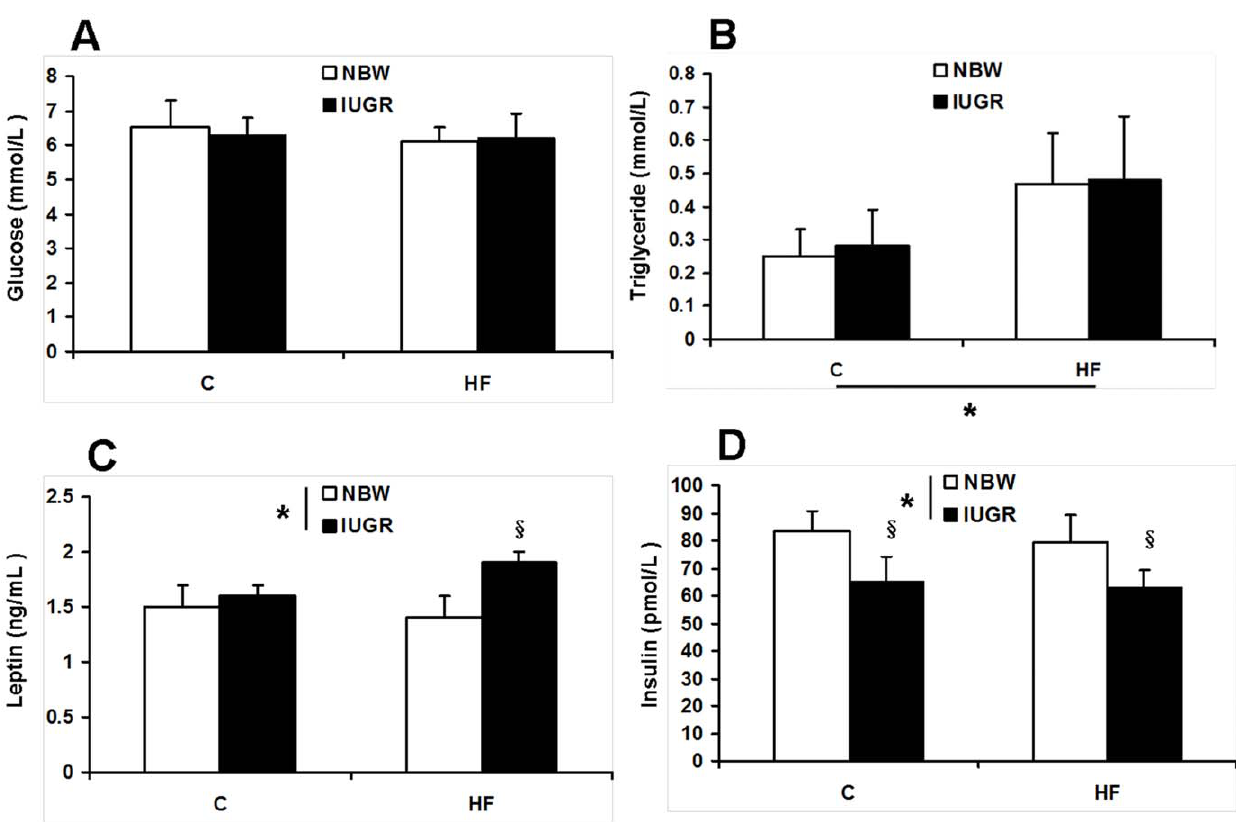
Figure 2. Influence of IUGR and diet on plasma concentrations of glucose (A), triglyceride (B), leptin (C) and insulin (D). C: Control diet; HF: High-fat diet; NBW: Normal birth weight; IUGR: Intrauterine growth retardation. Data are expressed as group means 6 SEM. * P values next to each label represent the significance in the effect for each source of variation (IUGR or diet) as calculated by ANOVA. 1 P , 0.05 in post hoc test comparing IUGR and NBW offspring receiving the same diet (n=8 by group).